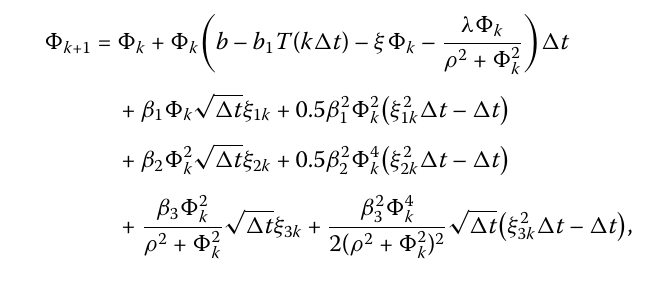
Figure 1 Trajectories of model (4) with b = 0.4, b 1 = 0.2, T ( t ) = 0.25 + 0.1sin t , ξ = 0.3, λ = 0.2, ρ = 0.1, β 2 β 2 β 2 2 = 0.1, 3 = 0.2. ( a ) 1 = 0.36, which reflects the extermination of the species. ( b ) the nonpersistence in mean of the species. ( c ) β 2 1 = 0.25, which reflects the weak persistence of the species. ( d ) β 2 1 = 0.04, which reflects the permanence of the